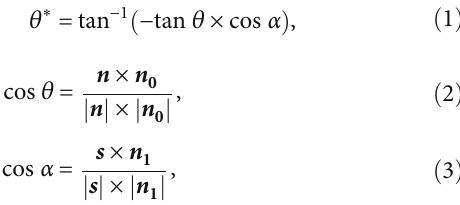
Figure 4: CSS-1950 biaxial rheological rock tester.